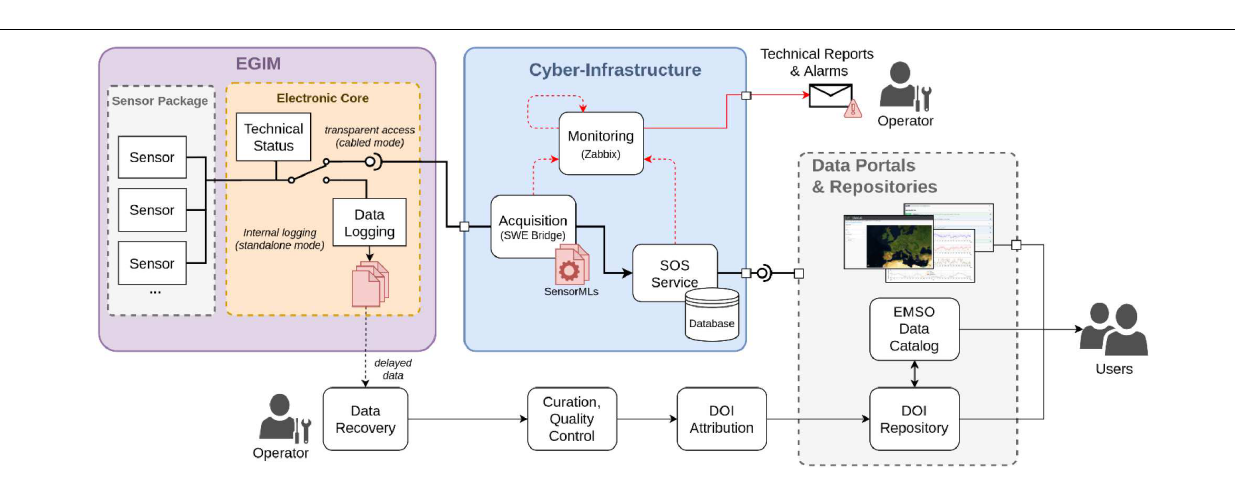
FIGURE 4 | Data flow from the sensor to the end